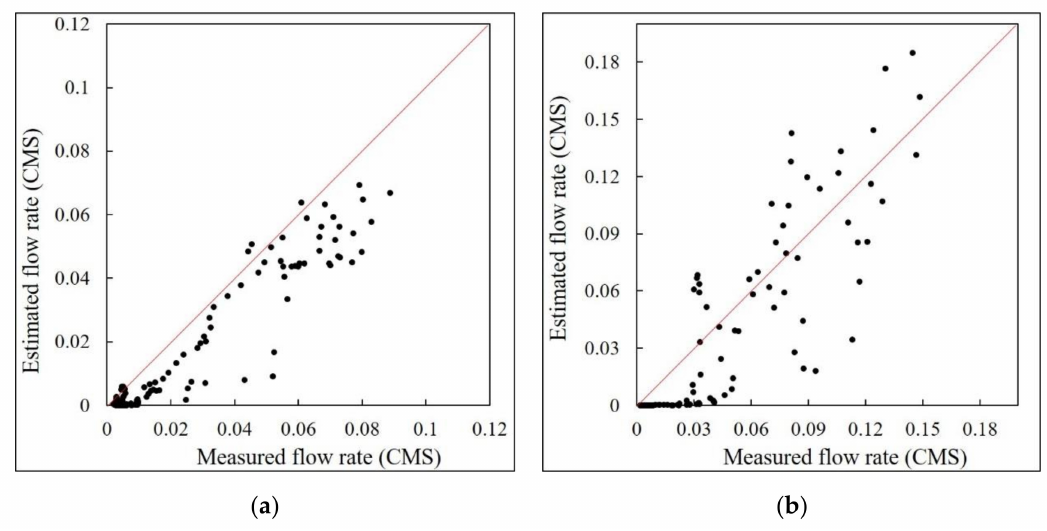
Figure 9. Calibration ( a ) and validation ( b ) of SWMM model for stormwater runo ff . Table 3. SWMM model calibration and validation results for suspended solid and total phosphorus. Suspended Solid Total Phosphorus Measured Estimated Di ff erence Measured Estimated Di ff erence (kg) (kg) (%) (kg) (kg) (%) Calibration 112.51